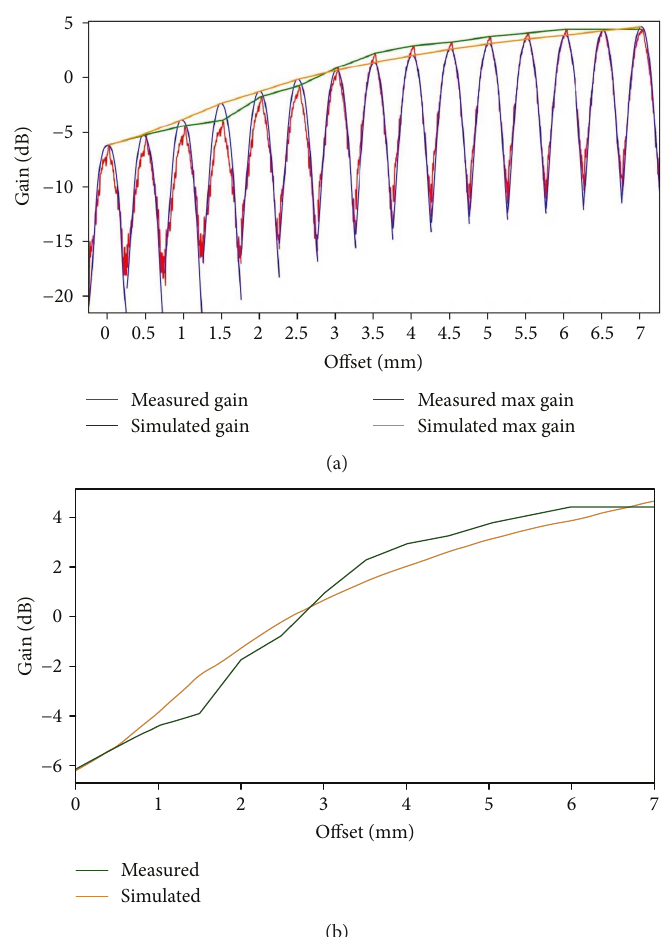
Figure 9: Measured unmatched 245 Ω edge-fed liquid-metal antenna versus simulated unmatched 245 Ω edge-fed liquid-metal antenna: (a) measured and simulated gains of 15 states; (b) measured and simulated maximum gains of 15